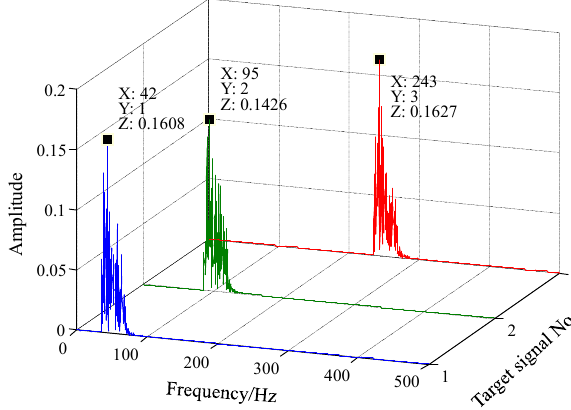
Figure 7. Three-dimensional spectrogram of the multi-frequency non-harmonic signal processed by FERSR and frequency recovery.